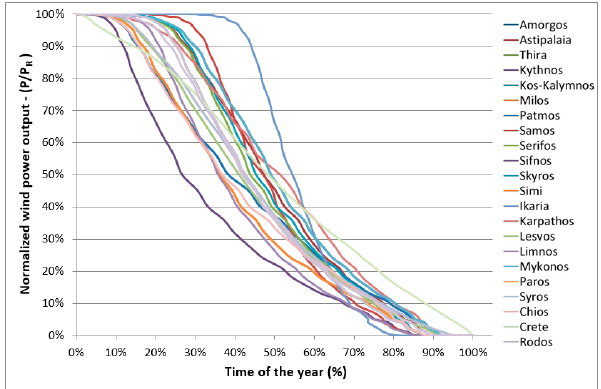
Figure 10. Annual duration curves of wind power output in all the examined case studies.